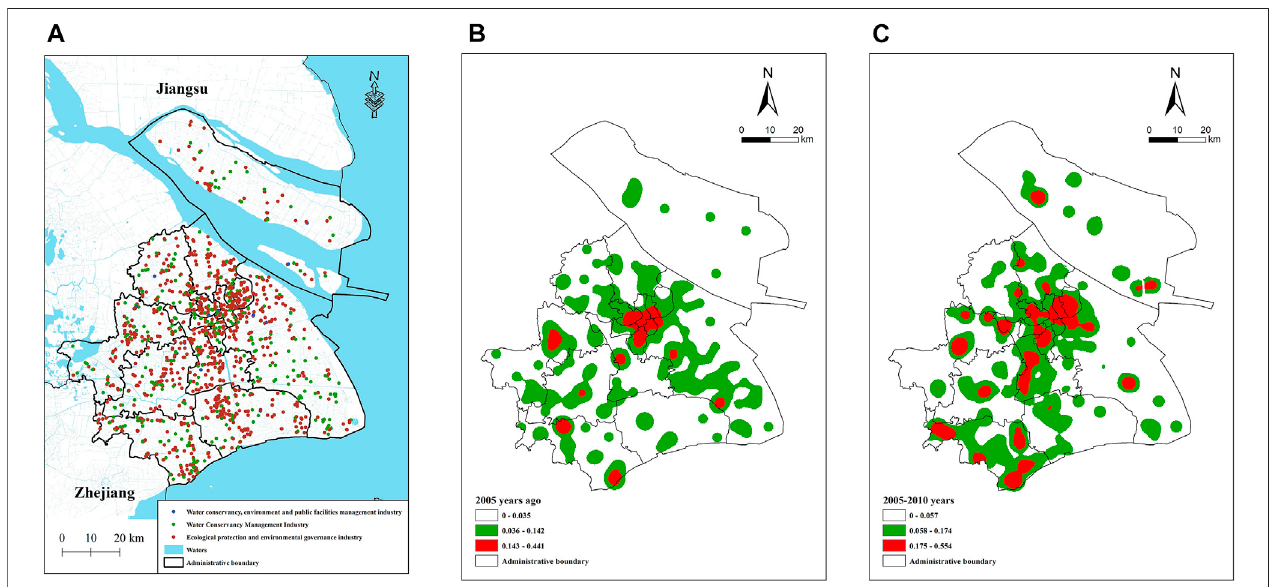
FIGURE 1 | Distribution map of MEG entities and institutions in Shanghai up until 2021 (A – C)